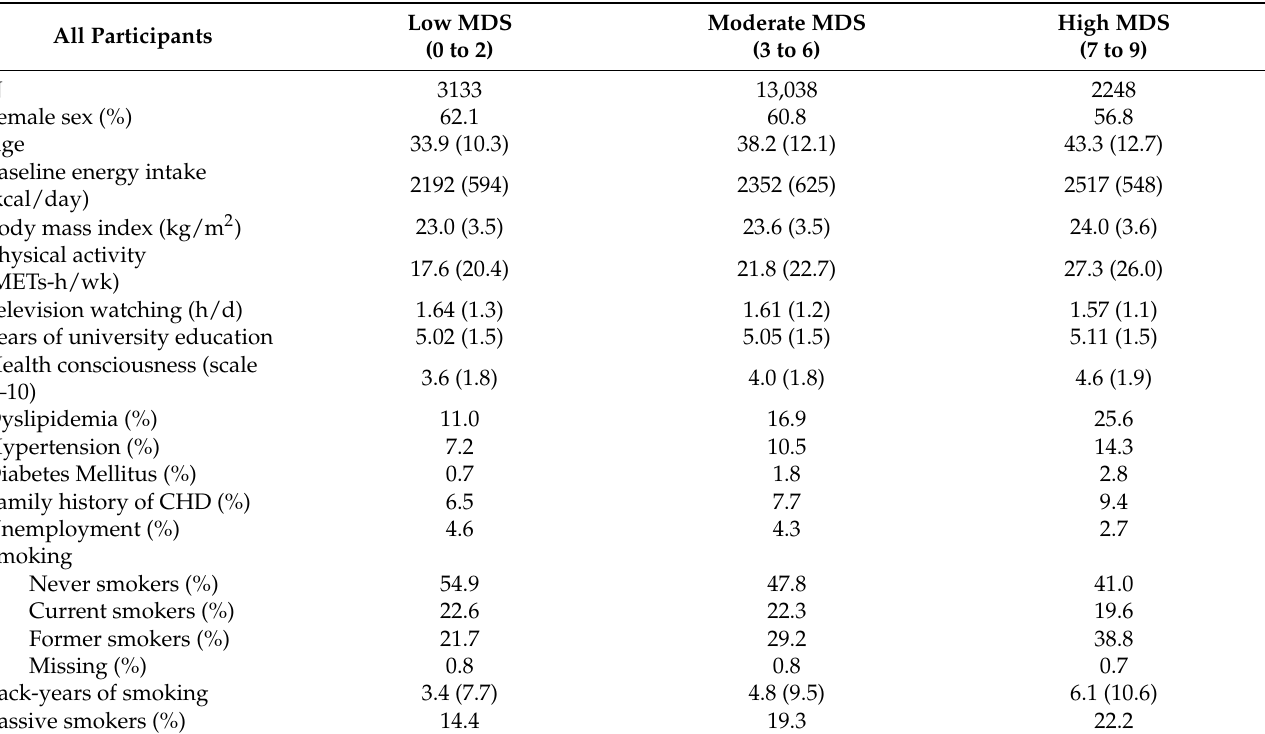
Table 1. Baseline characteristics according to baseline MedDiet adherence (MDS) in the “Seguimiento Universidad de Navarra” (SUN) cohort,